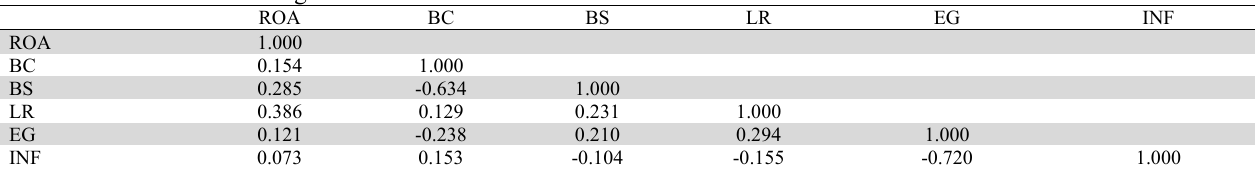
Correlation coefficients among variables